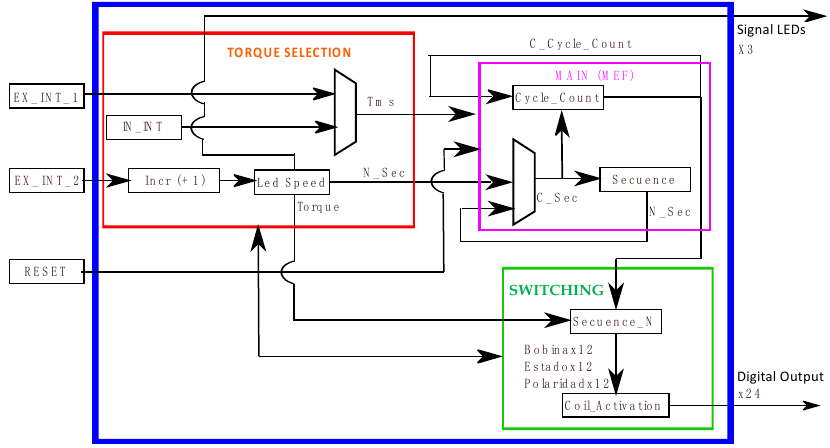
Figure 9. Block diagram of speed and torque control system.